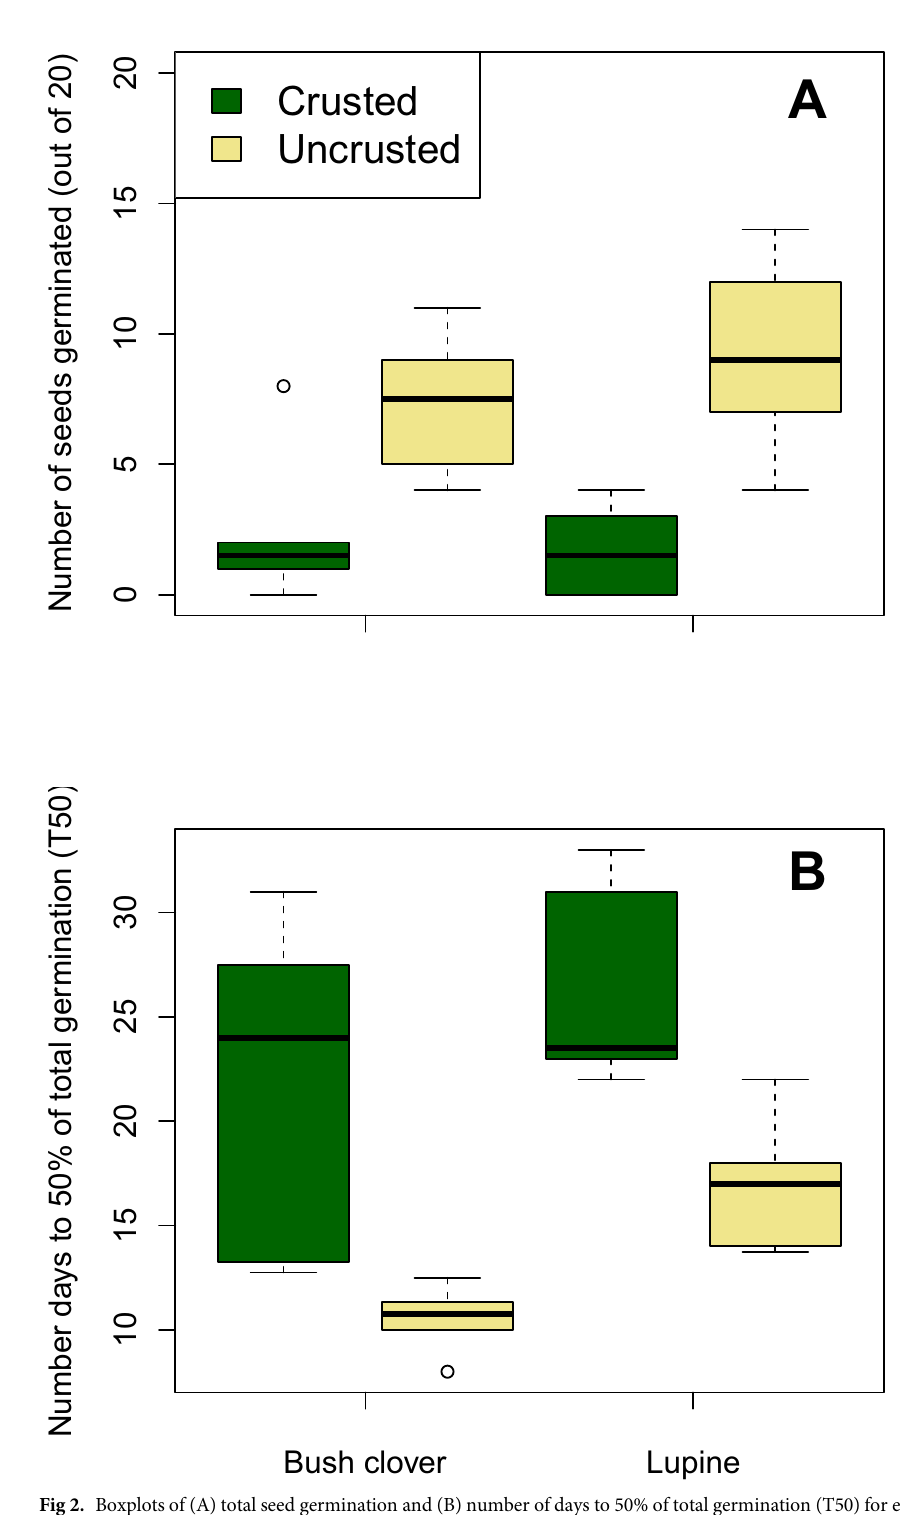
Fig 2. Boxplots of (A) total seed germination and (B) number of days to 50% of total germination (T50) for each soil type x plant species combination. The box in each box- and- whiskers plot represents the 25th and 75th percentiles, while the line in the middle of the box is the median (50th percentile). The top and bottom whiskers extend to the most extreme data points that are no more than 1.5 times the interquartile range from the box. The open circle is an outlier beyond the whiskers. Total seed germination was lower, and T50 was longer, on crusted soils compared to